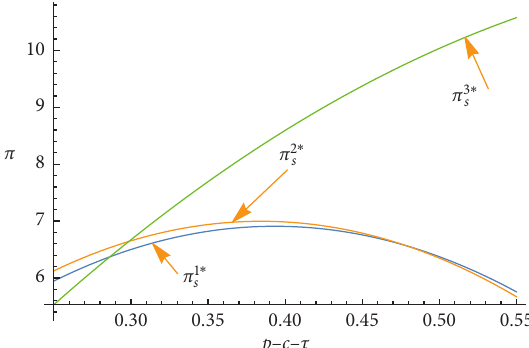
Figure 6: Effects of the marginal profit ( p − c − τ ) on the supplier’s presale